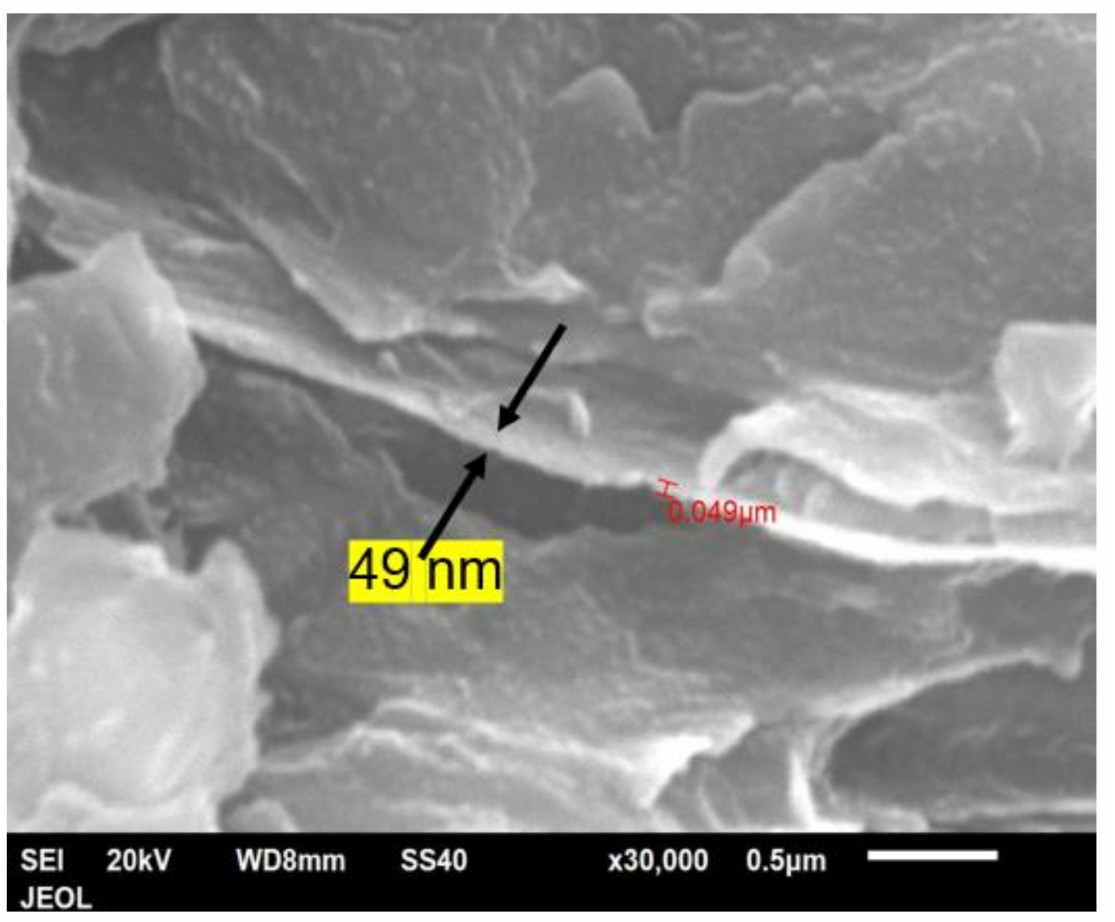
Figure 20. High-magnification SEM image of the 25 vol.% Al platelet–PET composite; the Al platelet is 49-nm thick and about 2- µ m wide. The aspect ratio is